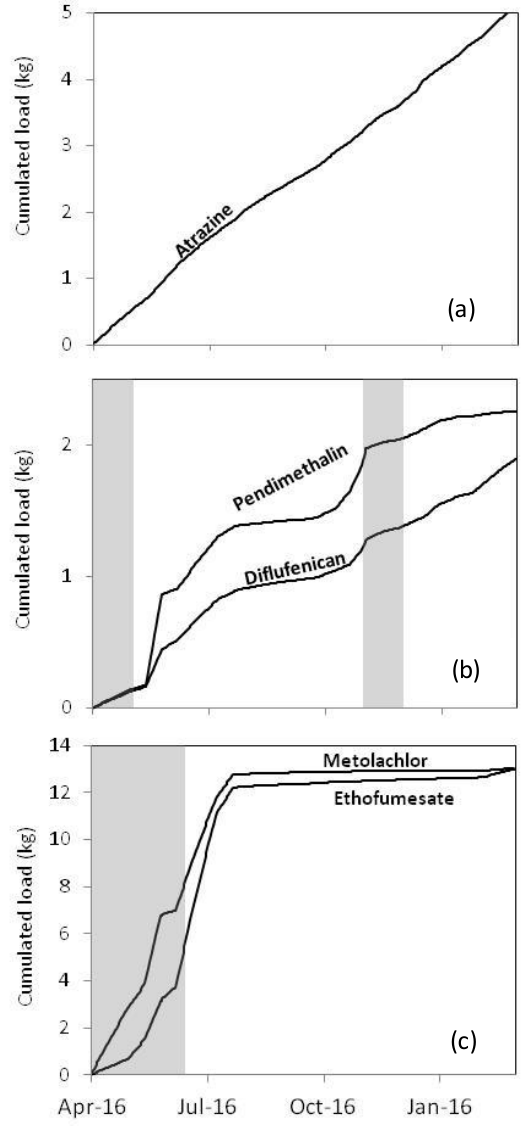
Figure 5. Cumulated fluxes for ( a ) atrazine, ( b ) pendimethalin and diflufencan and ( c ) metachlor and ethofumesate at Canche 5, from continuous monitoring by passive samplers. Values were normalized to May 2016 baseline. Grey areas refer to the estimated application period of the corresponding substances.